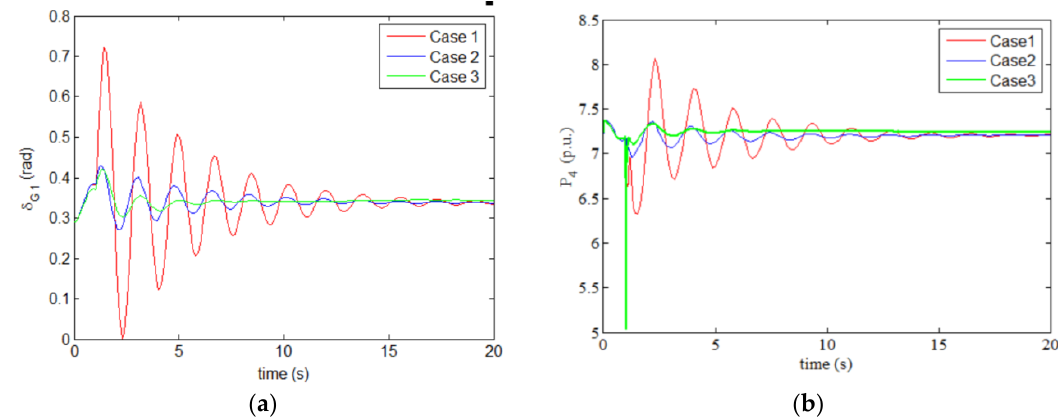
Figure 9. Response curves under different cases: ( a ) power angle curves of G 1 , and ( b ) active power output curves of G 4 .